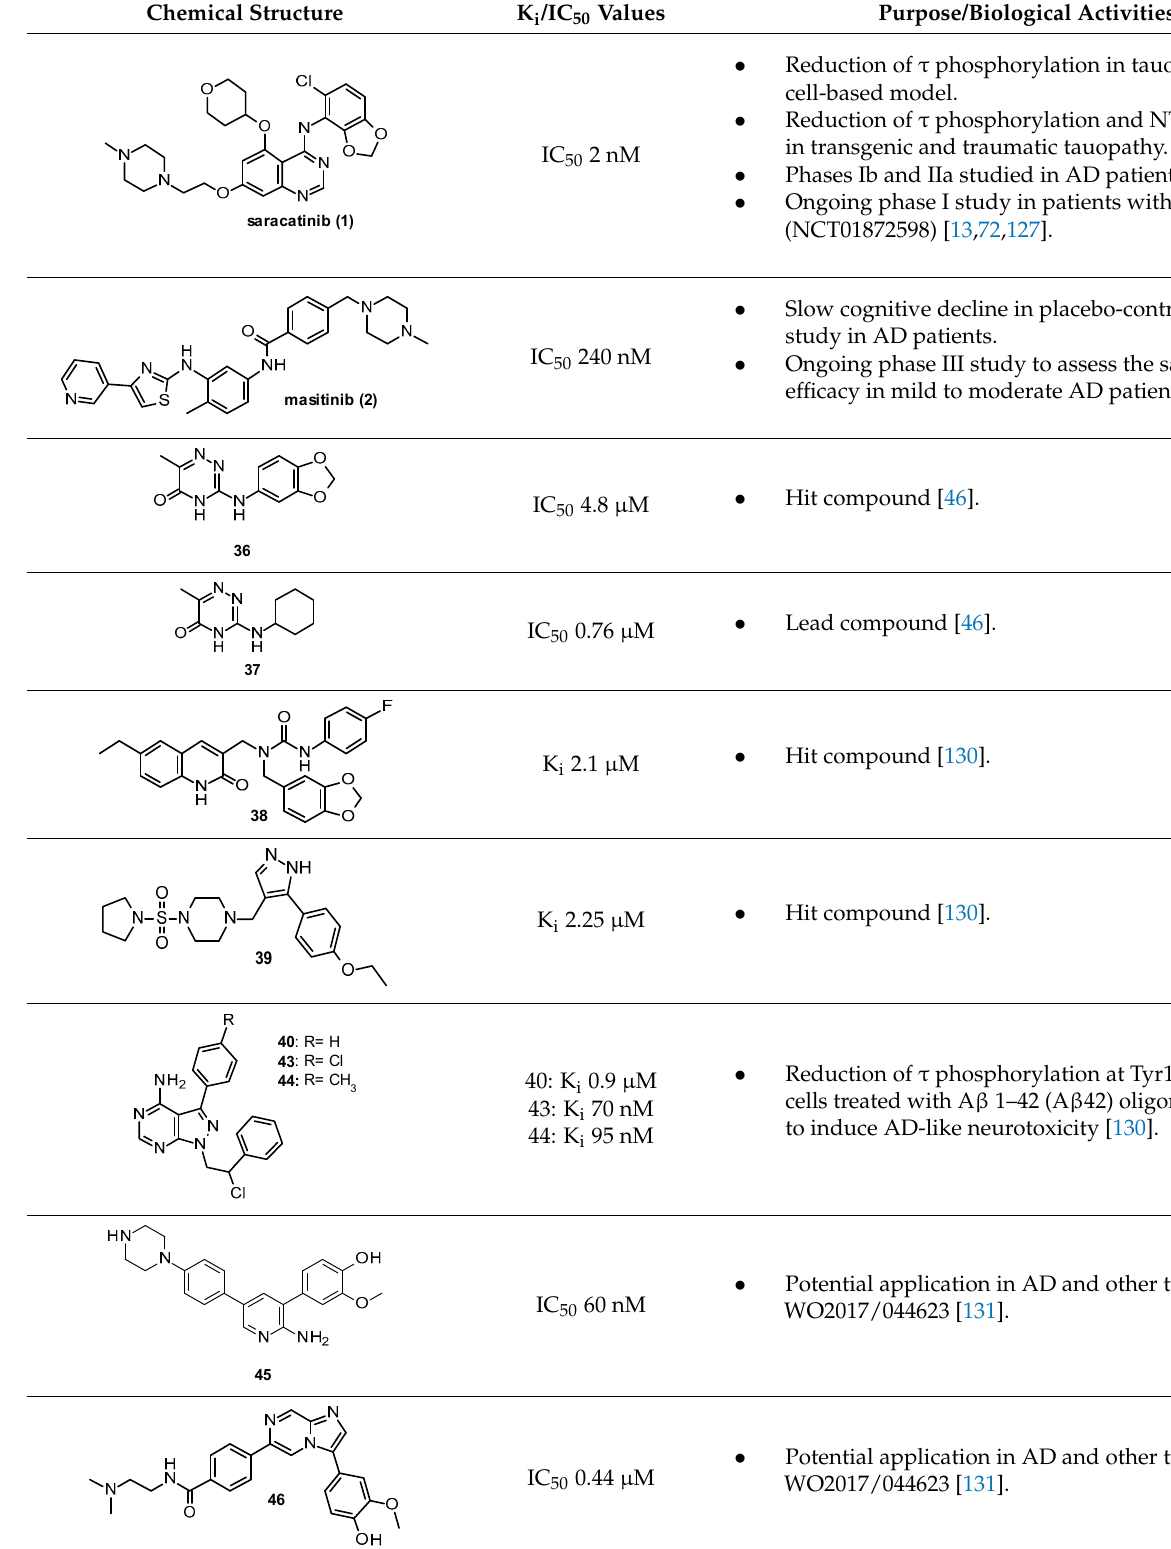
Table 2. ATP-competitive FYN inhibitors and their applications.